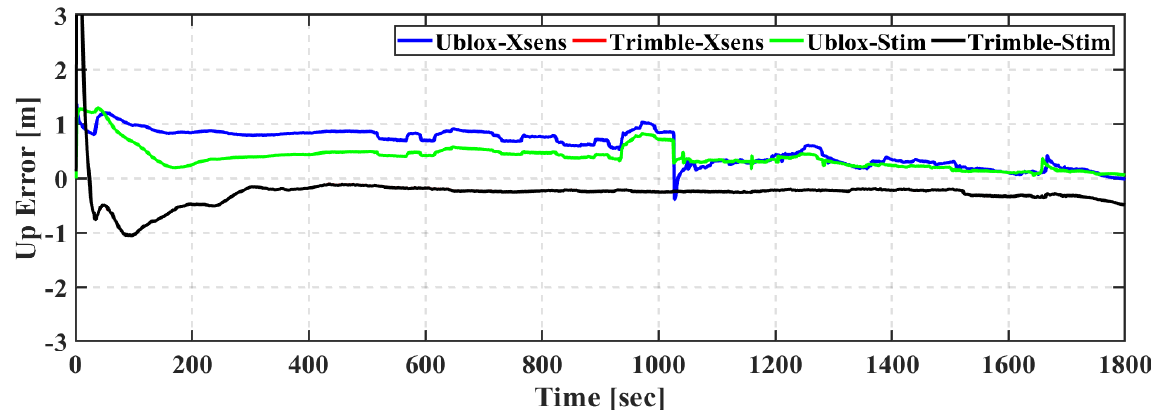
Figure 7. First field trial: Up positioning error of real-time TC GNSS PPP/INS for Ublox–Xsens, Trimble–Xsens, Ublox–Stim, and Trimble–Stim solutions.